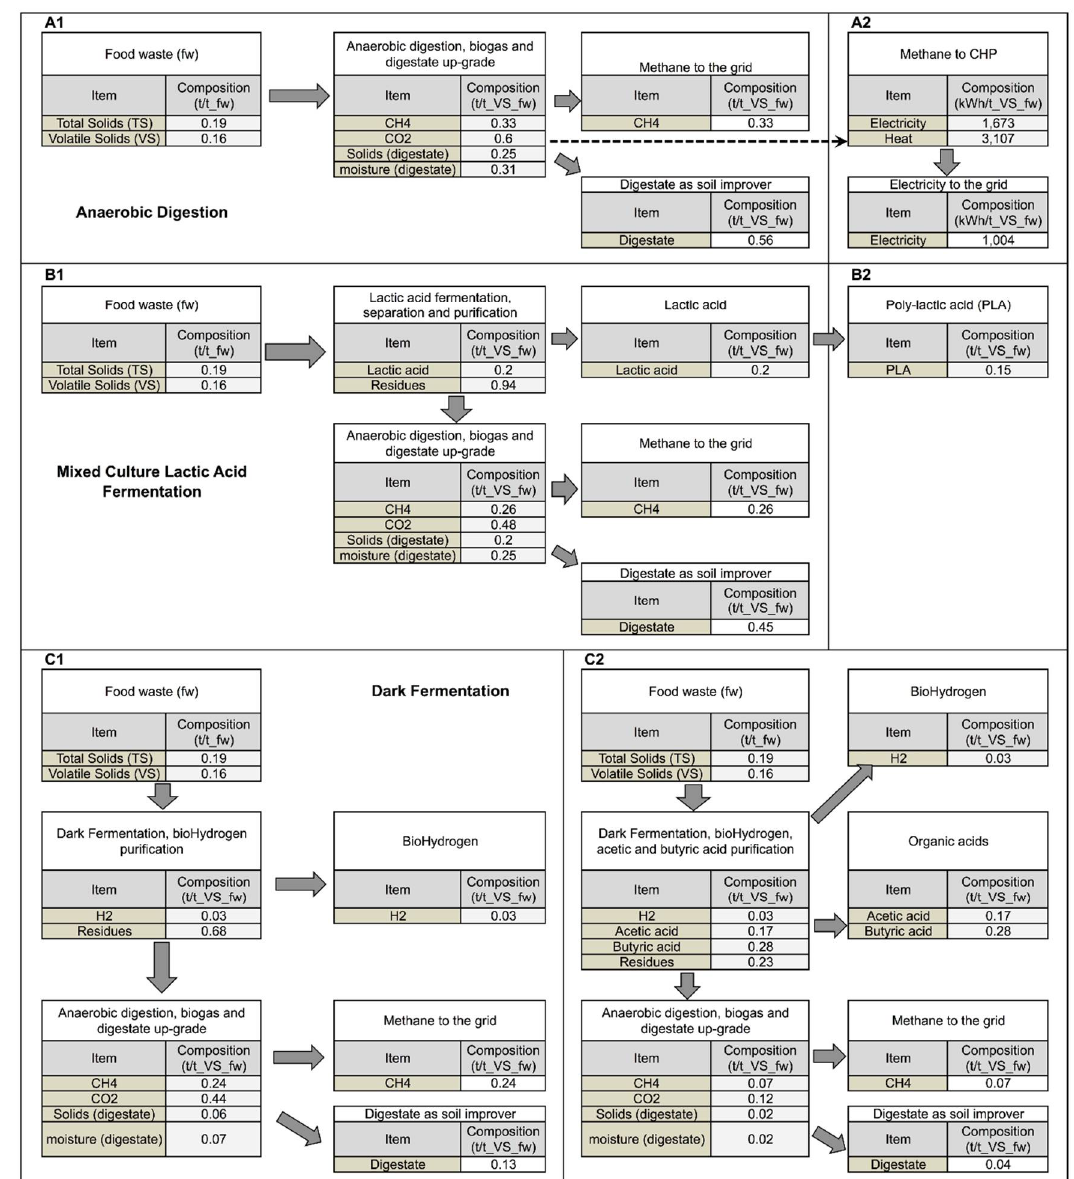
Figure 2. Mass flow diagram (t/t_VolatileSolid_foodwaste) for the different assessed scenarios. Anaerobic digestion: ( A1 ) methane (to the gas grid) and digestate; ( A2 ) Electricity and digestate. Lactic acid fermentation combined with anaerobic digestion: ( B1 ) lactic acid, methane, and digestate; ( B2 ) Poly-lactic acid, methane, and digestate. Dark fermentation combined with anaerobic digestion: ( C1 ) hydrogen, methane and digestate; ( C2 ) hydrogen, acetic acid, butyric acid, methane and digestate.